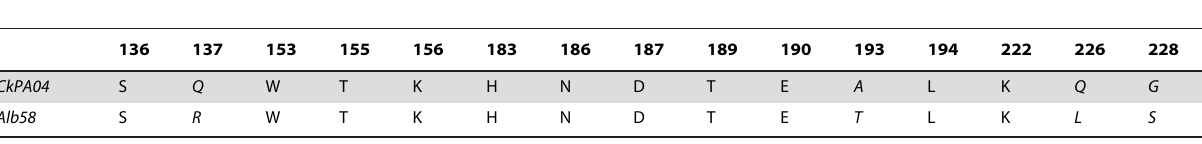
Table 1. Comparison of key amino acids in the RBS of CkPA04 and Alb58